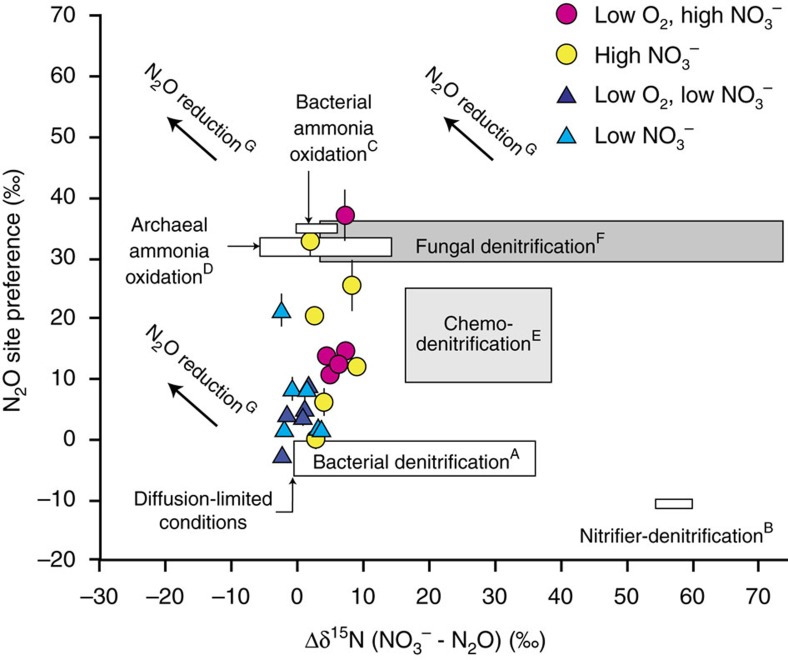
Multiple isotope plot of N2O illustrating predicted compositional fields of various processes as well as steady-state composition of N2O fluxes from incubations.For illustrating representative compositional fields of N2O production processes (boxes), ranges are taken from literature reports of the offset between precursor molecule and predicted N2O (Δδ15N, or the difference in δ15N between NH4+ and N2O for bacterial and archaeal ammonia oxidation, between NO2− and N2O for chemodenitrification or between NO3− and N2O for denitrification). References (in parentheses) include for (A) bacterial denitrification208384, (B) nitrifier-denitrification59, (C) bacterial ammonia oxidation20598485, (D) archaeal ammonia oxidation565758, (E) chemodenitrification474849, (F) fungal denitrification37424344 and (G) bacterial N2O reduction212286, which has been shown to result in a coupled increase in δ15N and SP of the remaining N2O pool (indicated by arrows). Experimental x-axis data are δ15NNO3–δ15NN2O. Error bars in the y-direction are 1 s.d., while in the x-direction error is smaller than the symbols. Note that for mass balance calculations the actual measured steady-state isotope values of precursor molecules (for example, NH4+ or NO3−) were used as appropriate for constraining endmember values of each process. In general, addition of ∼100 μM NO3− to the overlying water increased N2O fluxes with an accompanying increase in N2O site preference, while not decreasing the Δδ15N (as would be expected from N2O reduction, arrows), implicating an increased production of N2O from a process deriving from NO3− (or NO2−) yet also one yielding an elevated site preference such as chemodenitrification and/or fungal denitrification.